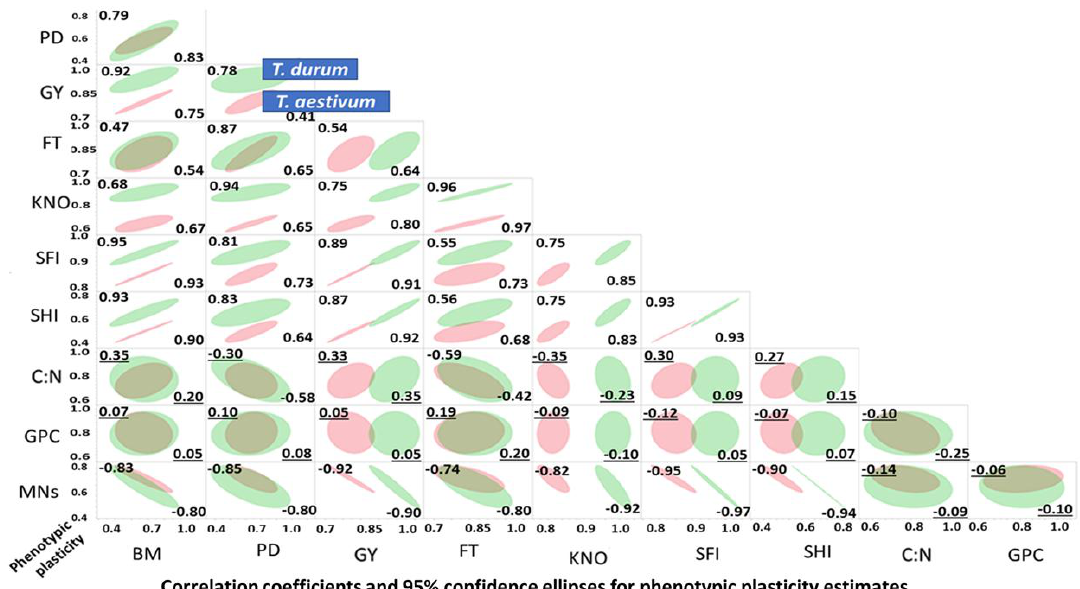
Figure 3. Bivariate correlation coefficients, graphical discriminant analysis and semi-quantitative description of bivariate distributions and associations (95% ellipsis) between phenotypic plasticity estimates of agronomic and micronutrient traits in T. durum genotype (red) and T. aestivum genotype (green) subjected to abiotic stress.